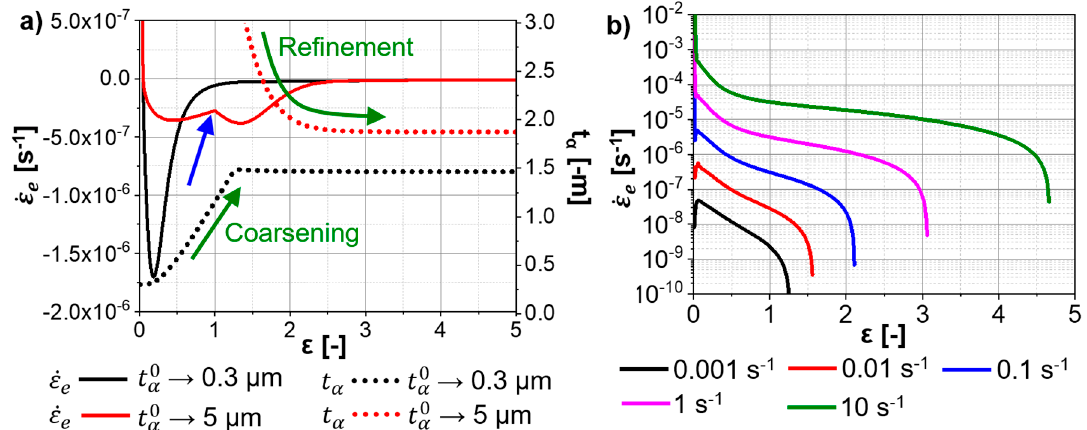
Figure 13. Evolution of the global elastic strain rate predicted by “Model G” for the Ti-17 deformed at ( a ) 810 °C and 0.001 s − 1 , and ( b ) 970 °C. The evolution of the aspect ratio and α -thickness are shown in ( a ) for the initial α -thicknesses of 0.3 µm and 5 µm.